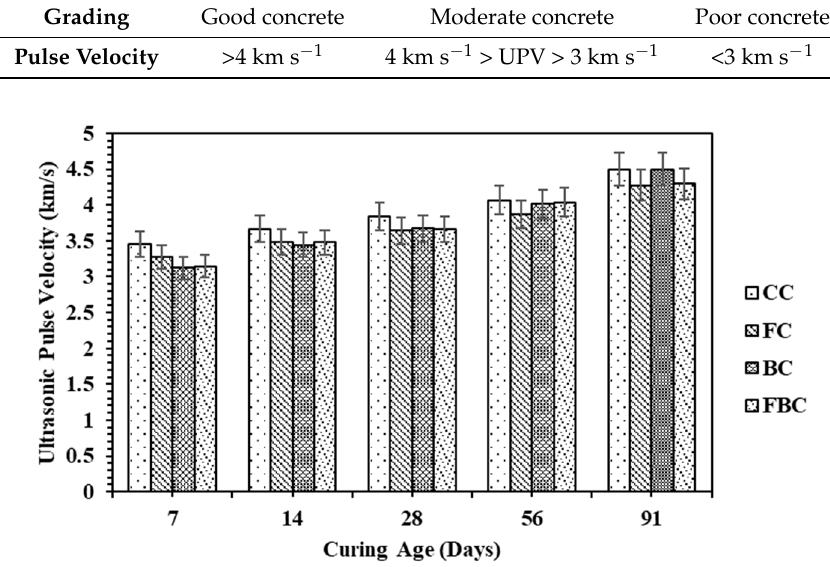
Table 4. Quality of concrete corresponding to UPV values [26].